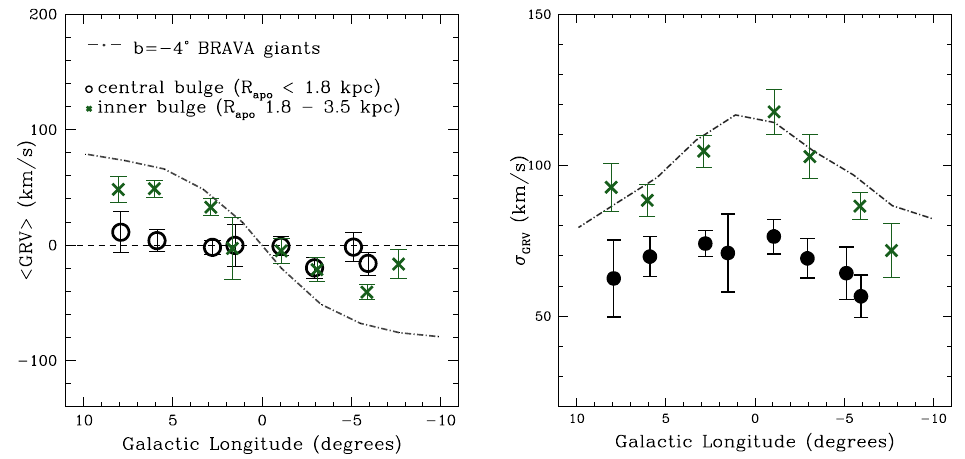
Figure 8. ( Left ) The mean velocity for RR Lyrae stars in the BRAVA-RR survey as a function of Galactic longitude. ( Right ) The velocity dispersion profile for the same stars. The lines represent the model by Shen et al. (2010) with a pure bar and no classical component.